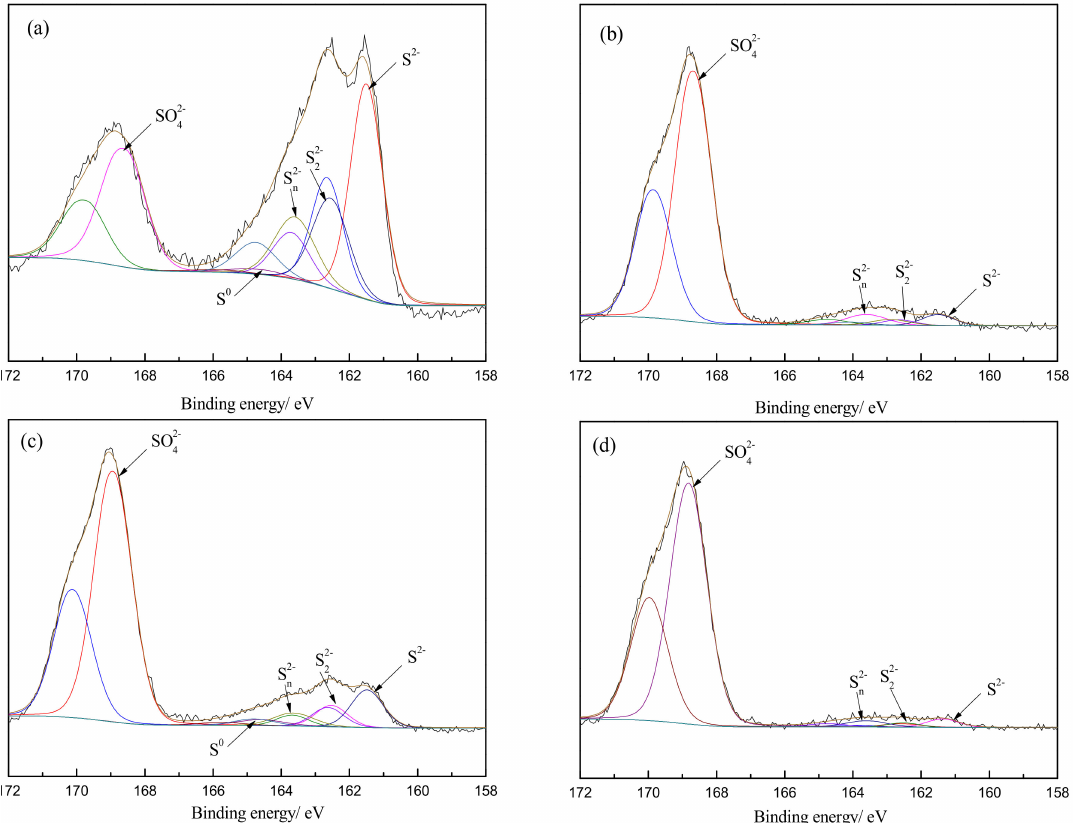
Figure 15. S 2p XPS spectra of leached pentlandite with di ff erent conditions: ( a ) pH = 2.00, leached for 8 days; ( b ) pH = 2.00, leached for 16 days; ( c ) pH = 3.00, leached for 8 days; ( d ) pH = 3.00, leached for 16